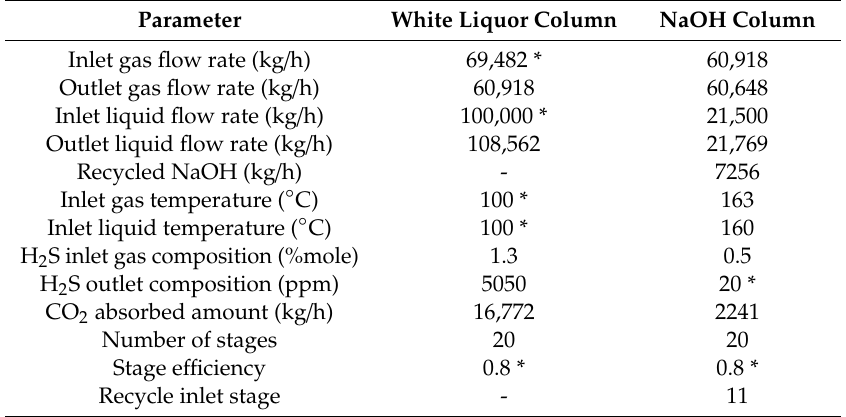
Table 9. Operating data and simulation results of white liquor and NaOH acid gas absorber. * model input parameters. Parameter White Liquor Column NaOH Column Inlet gas flow rate (kg / h) 69,482 * 60,918 Outlet gas flow rate (kg / h)